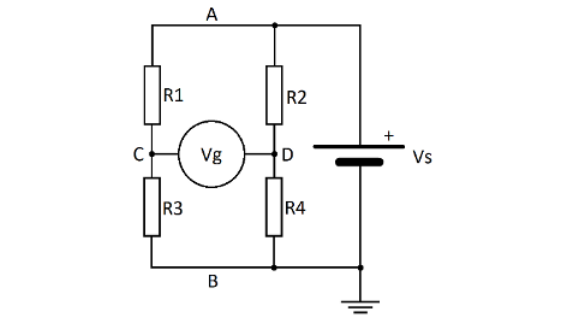
Figure 5. Schema of the Wheatstone